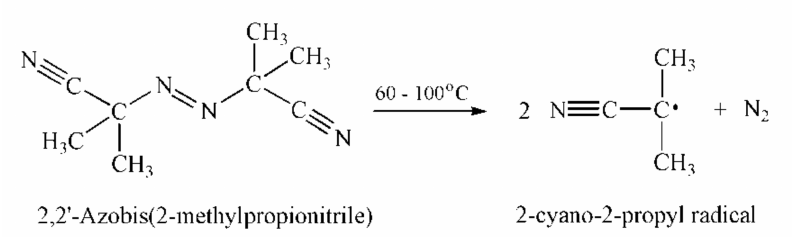
Figure 2. The formation of 2-cyano-2-propyl radical by degradation of 2,2’-azobis(2- methylpropionitrile).